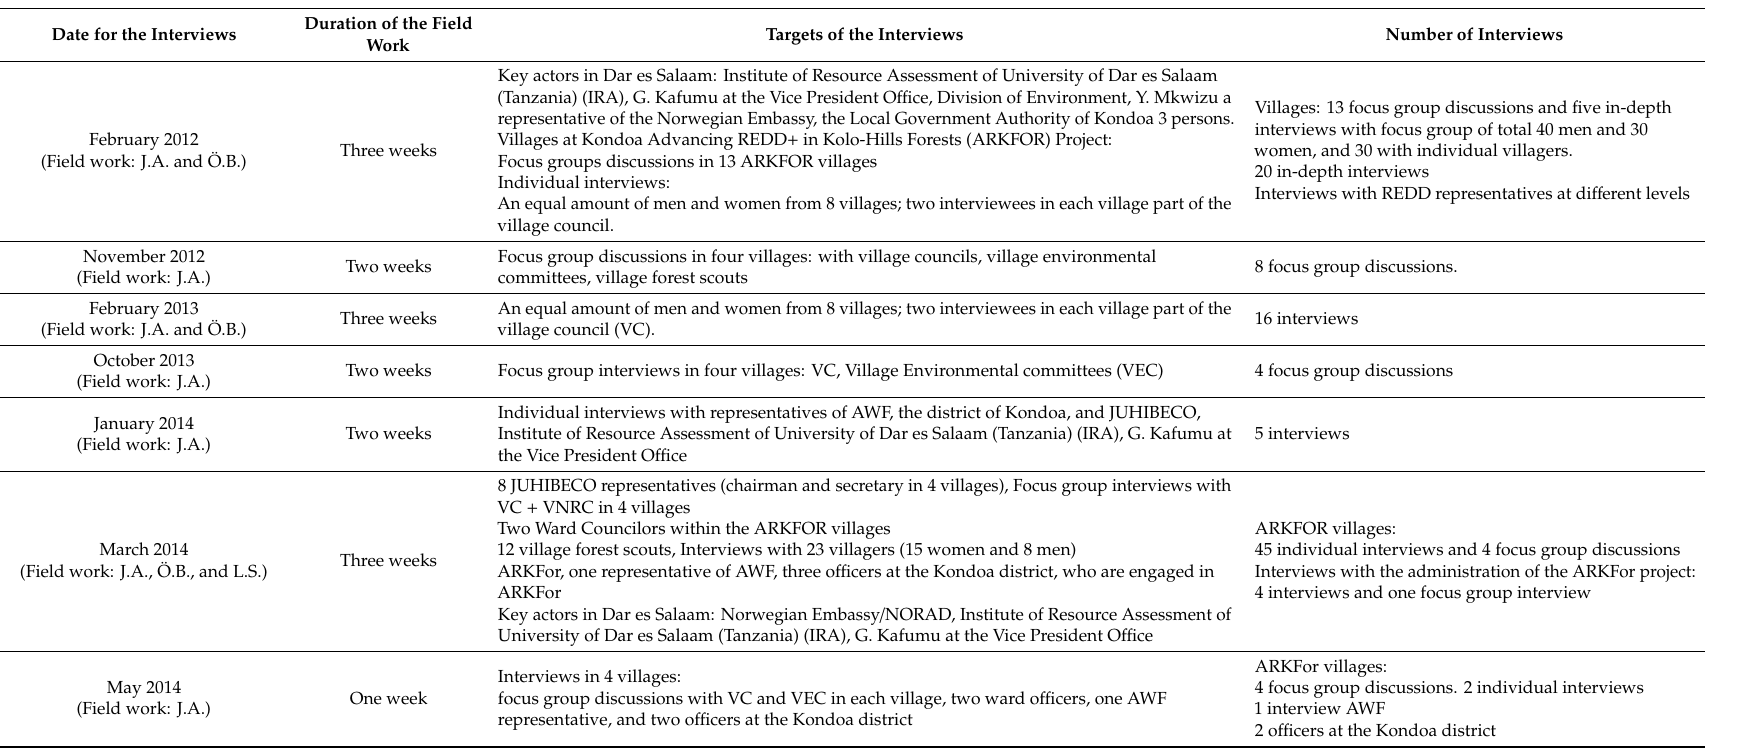
Table 1. Data on the interviews taking place during field